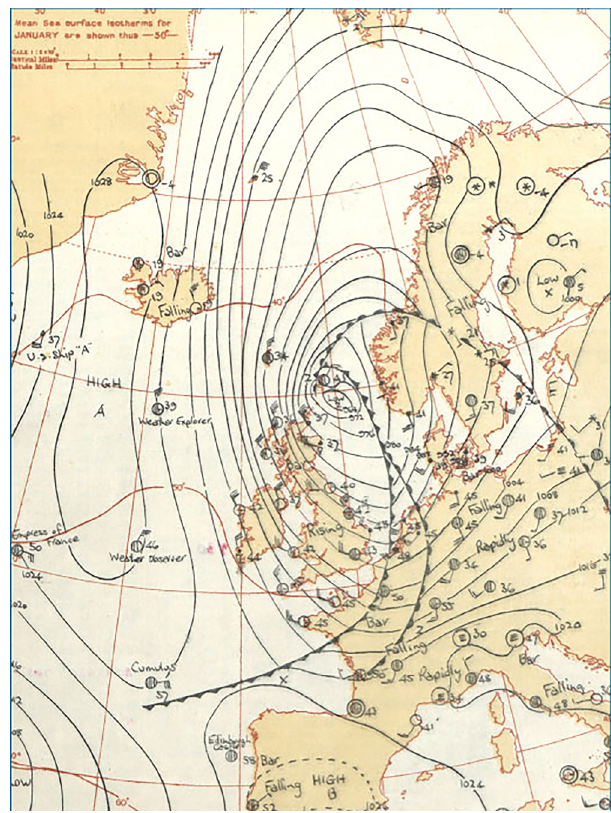
Figure 12. Surface pressure chart (hPa) at 06:00UTC on 1 February 1953 from